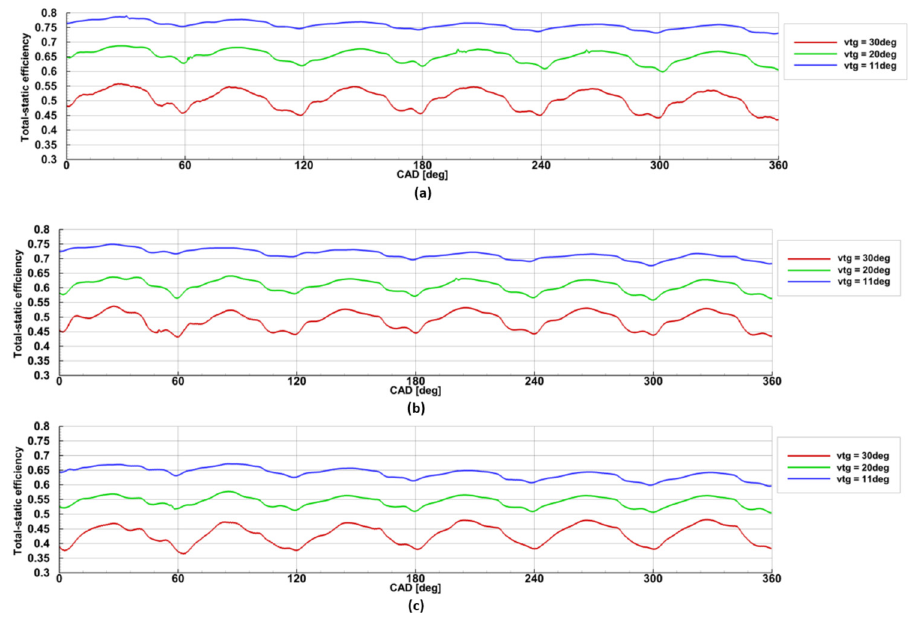
Figure 22. The averaged total-static efficiency of the 2nd stage rotor at the three different VTG openings for: ( a ) 60,000 rpm, ( b ) 50,000 rpm, ( c ) 40,000